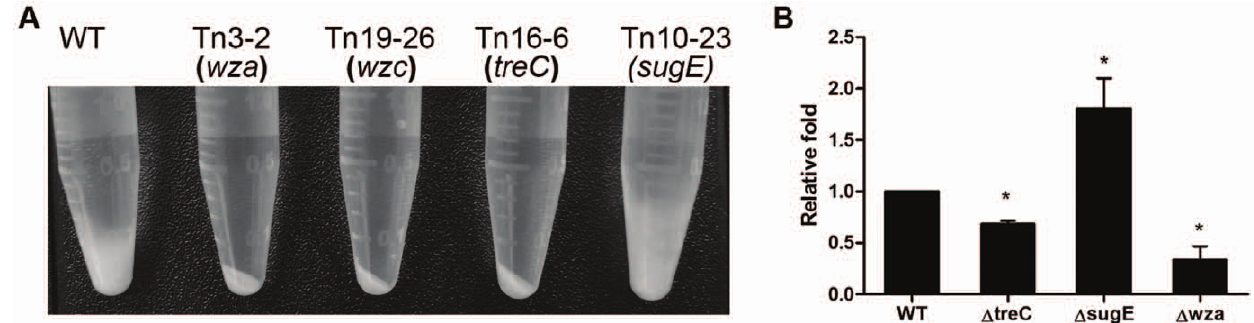
Figure 3. Mucoviscosity, capsular polysaccharide (CPS) production and biofilm formation of K.pneumoniae NTUH-K2044 and isogenic mutants. A, K. pneumoniae NTUH-K2044 and the transposon mutants Tn3-2 ( wza ), Tn19-27 ( wzc ), Tn16-6 ( treC ), and Tn10-23 ( sugE ) grown overnight were pelleted at 12,000 g for 10 min. B, The amount of CPS production nof the wild-type strain NTUH-K2044, treC , sugE , and wza mutants were determined by the sulfuric acid assay. *, p , .05. Data are representative of three independent experiments (triplicate in each